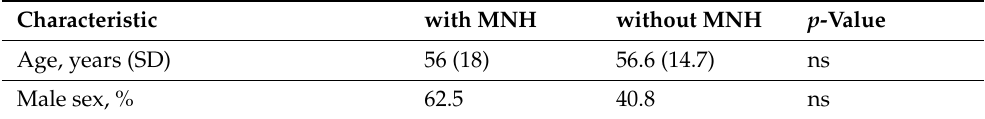
Table 7. Comparison between subjects with and without MNH among untreated